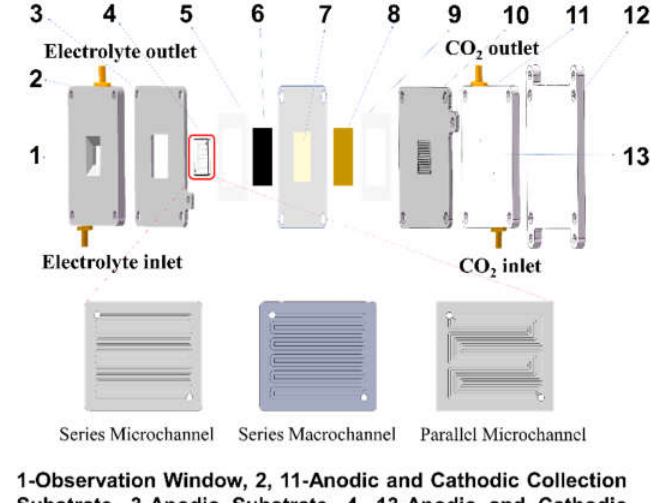
Figure 2. Assembly drawing of the membrane reactor with microchannels.